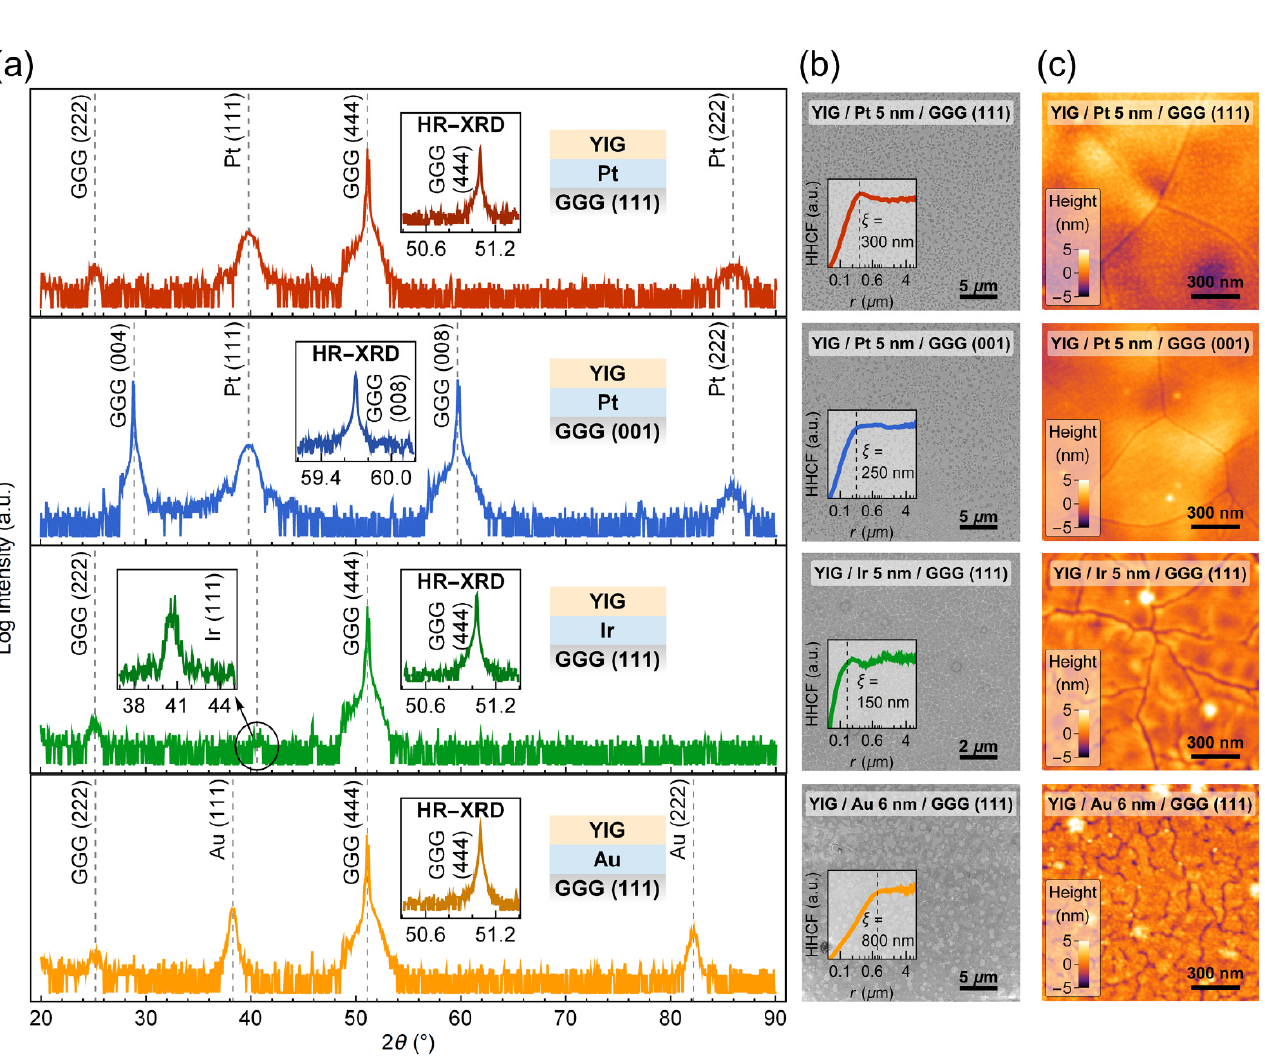
Figure 1. Structural properties of 40-nm-thick YIG films grown on GGG substrates with thin metal layers. ( a ) X-ray diffraction patterns recorded on samples with 5–7 nm metal underlayers. Note that the (222) peaks of the GGG substrate are so-called basis-forbidden reflections due to multiple diffraction [43]. Insets denoted as HR-XRD show high-resolution scans utilizing a four-crystal monochromator. The inset showing the Ir (111) reflection comes from a separate scan with a long statistical exposure. ( b ) SEM surface images. Insets show height-height correlation function (HHCF) as a function of lateral distance 𝑟 calculated on the basis of SEM contrast changes to evaluate the defect correlation length 𝜉 . ( c ) AFM topography maps.